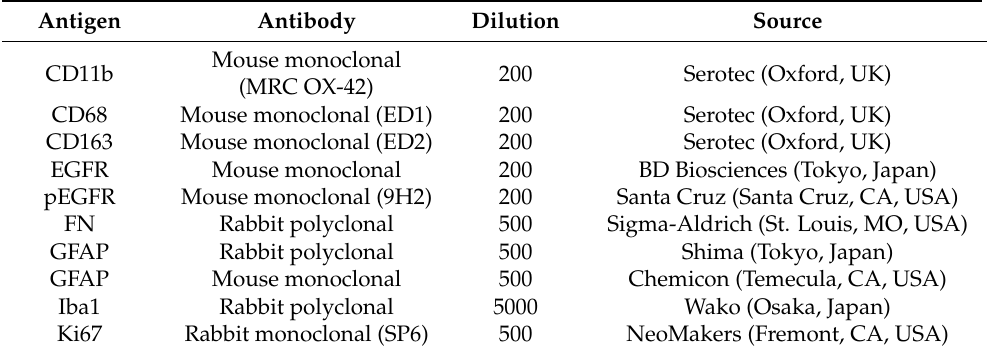
Table 1. Primary Antibodies used in this